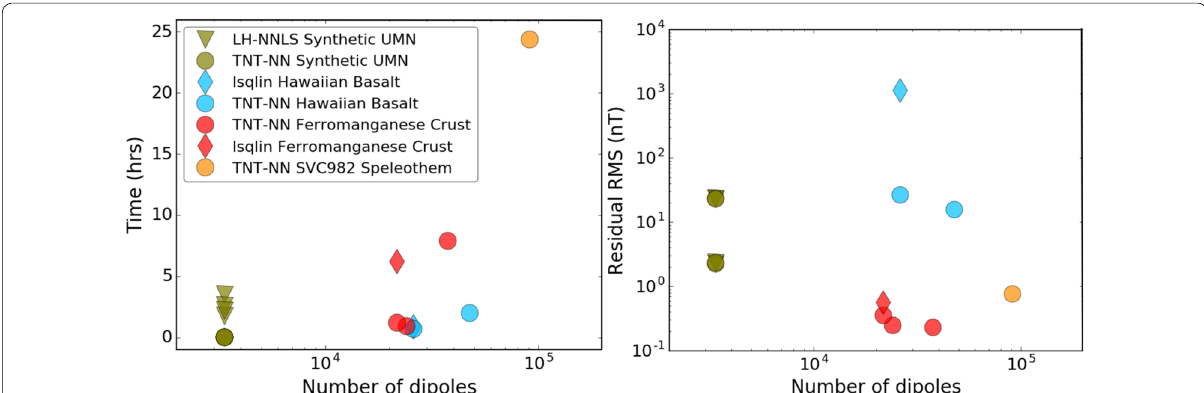
Fig. 11 Execution time (left) and residual RMS (right) results are shown for all samples. For these samples TNT-NN always produces a solution in less execution time than alternative methods. Like many linear algebra methods, TNT-NN execution time is strongly linked to problem size. Excluding trivial problems (the synthetic UMN logo), TNT-NN always produces residual RMS values that are less than or equal to those produced by competing methods. Without violating compact support, the residual RMS value produced by TNT-NN for a given sample is relatively consistent. Variations in resolution or increasing the measurement domain around the sample provides less than an order of magnitude improvement in residual